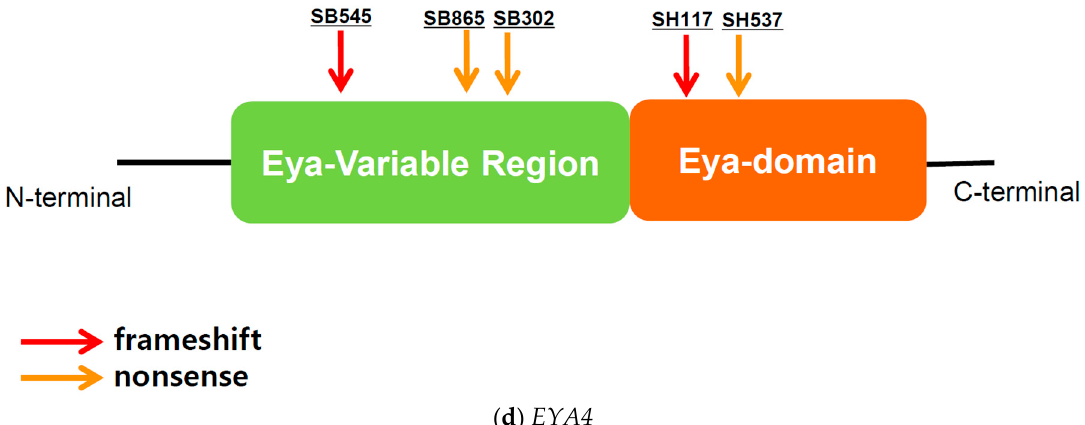
Figure 1. Physical map of variants caused by four transcription factor genes associated with non- syndromic deafness: ( a ) POU3F4 ; ( b ) POU4F3 ; ( c ) LMX1A ; ( d ) EYA4 .